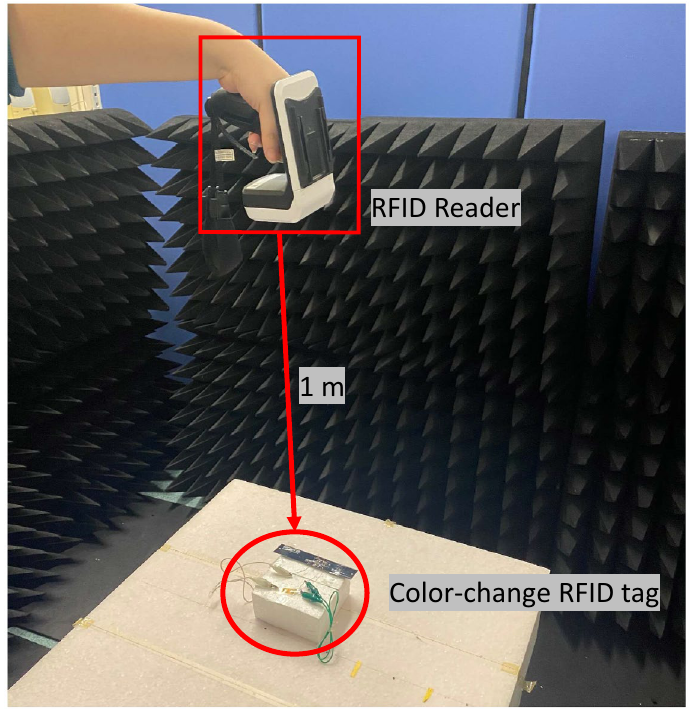
Figure 8. Irradiation experiment of color-change RFID tag at a 1 m distance using the RFID reader (DOTR- 3200 30 ) irradiating 1 W radio waves.